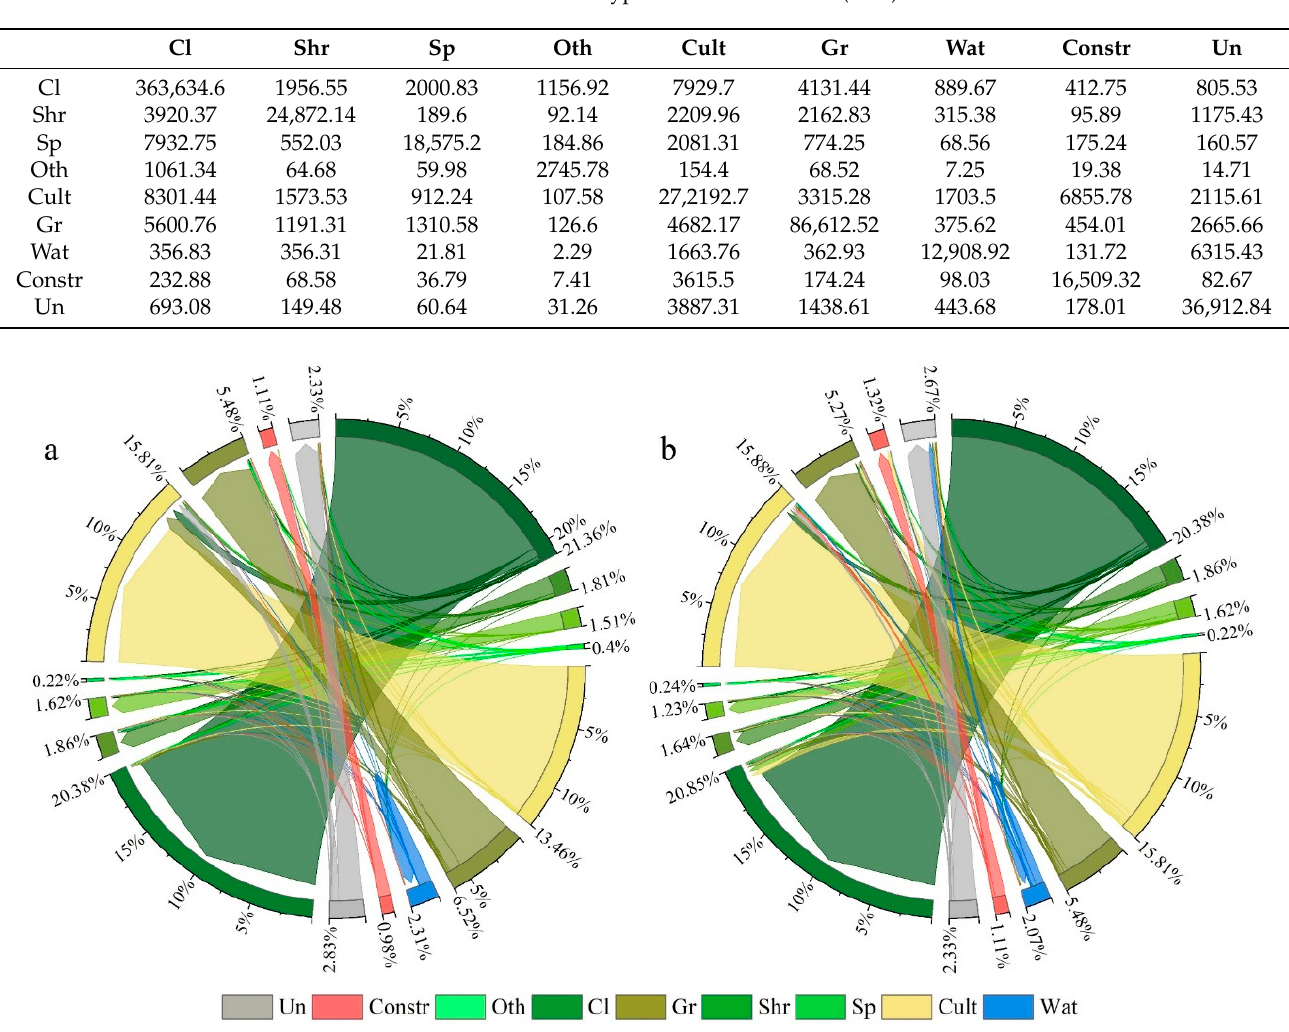
Figure 6. The relationship between land use conversion in different time periods (( a ) represents 1980–2000, ( b ) represents 2000–2020. The beginning of the arrow indicates the land proportion in the base year, and the arrow points to the land proportion in the target year).